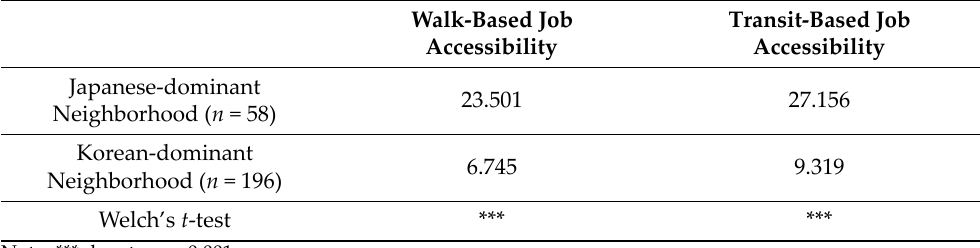
Table 3. The difference in job accessibility between Japanese-dominant neighborhoods and Korean- dominant neighborhoods.